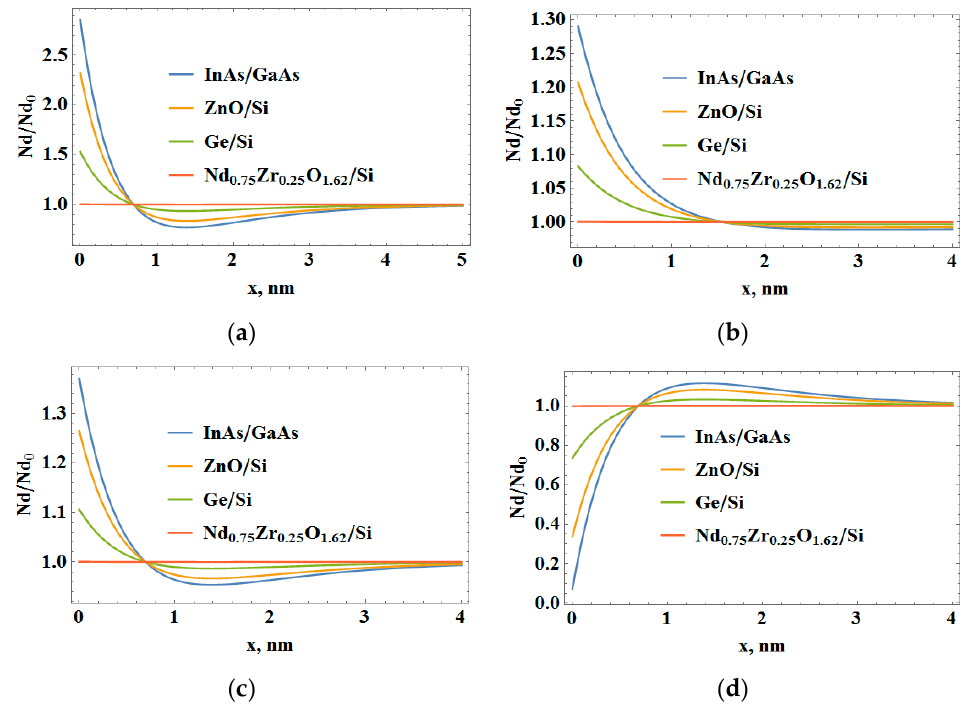
Figure 2. The spatial redistribution of point defects for their different types and for their different average concentration values: ( a ) θ d = 10 eV, N d0 = 0.1N dc ; ( b ) θ d = 10 eV, N d0 = 0.8 N dc ; ( c ) θ d = 5 eV, N d0 = 0.1 N dc ; ( d ) θ d = − 5 eV, N d0 = 0.8 N dc .